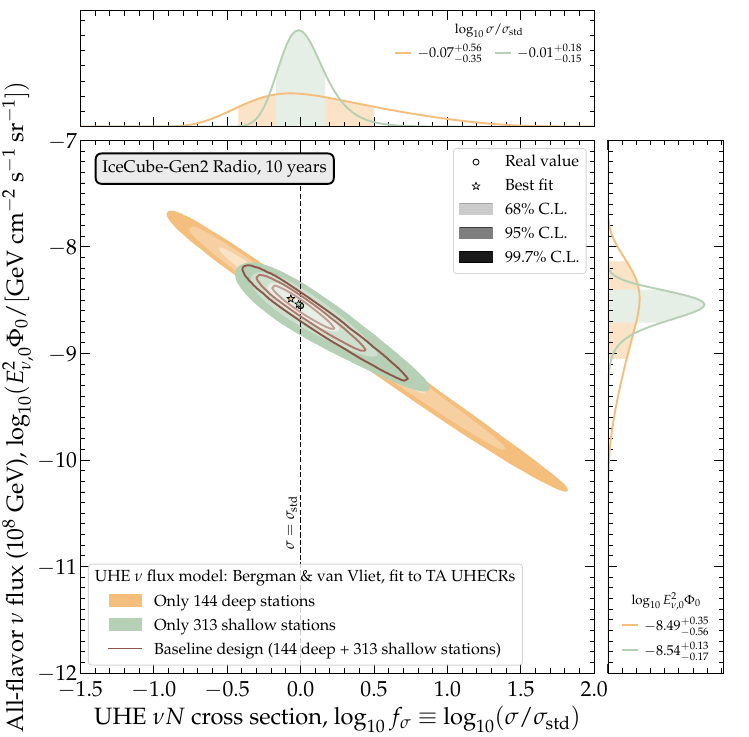
Figure 19 . Same as figure 17, but for benchmark flux model 4 alone, and showing results using only the deep and shallow stations of the baseline array